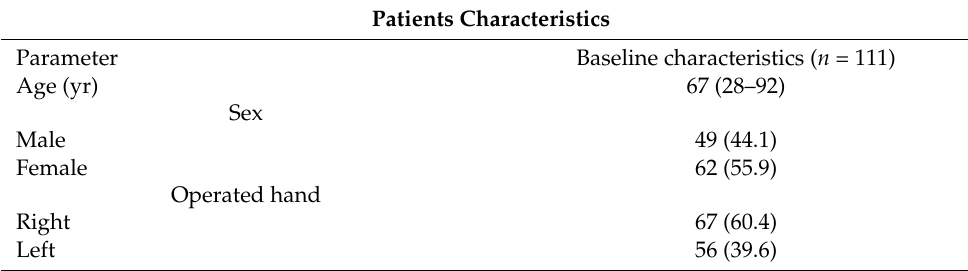
Table 1. Patients’ characteristics for first surgery.